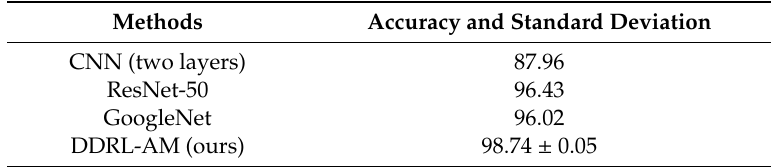
Table 5. Scene classification results (ac% ± std) using the EuroSAT dataset with 80% training